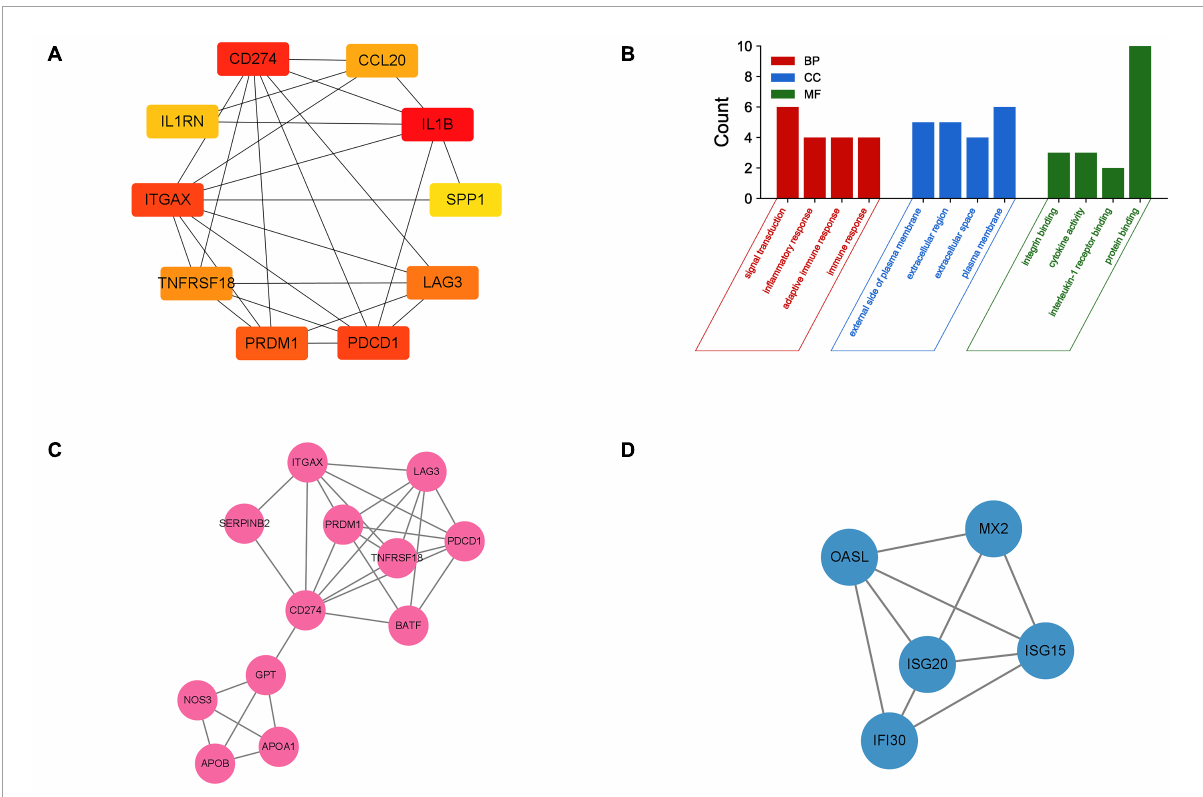
FIGURE5 Identification of hub genes and two core modules. (A) The top 10 most significant hub genes identified using the plugin cytoHubba. (B) GO analysis of 10 hub genes. (C,D) Two key modules identified by